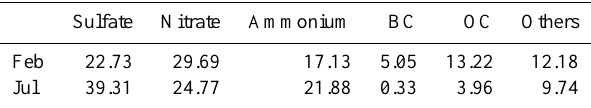
Table 4. Regional- and monthly-average extinction contribution ra- tios (%) of sulfate, nitrate, ammonium, BC, OC, and other aerosols (dust, sea salt, and unspecified anthropogenic mass) in February and July in Beijing. Sulfate